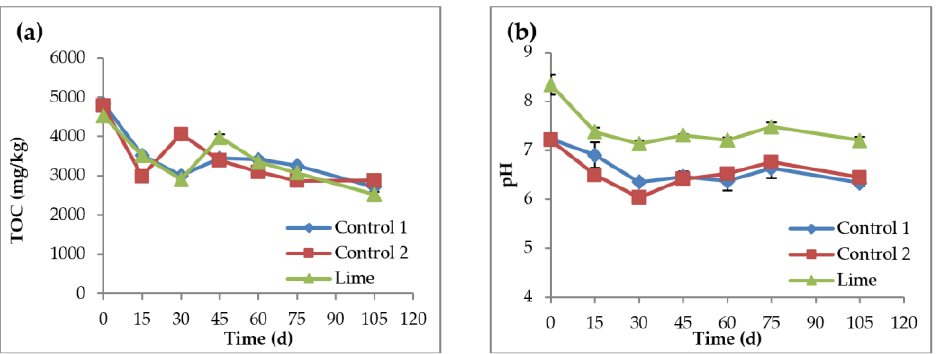
Figure 4. Total organic carbon concentration ( a ) and pH ( b ), over time. Control 1 is the soil reactor that received untreated sludge with no nanoparticles, control 2 is the soil reactor that received untreated sludge with 2 mg AgNPs/g TS sludge, and lime is the soil reactor that received lime treated sludge with 2 mg AgNPs/g TS sludge.